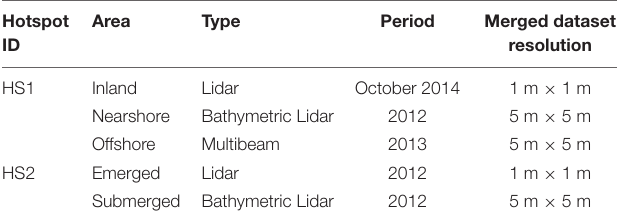
TABLE 1 | Topo-bathymetric dataset, input for the XBeach (1D Topo-bathymetric profiles) and Lisflood (2D Topography)